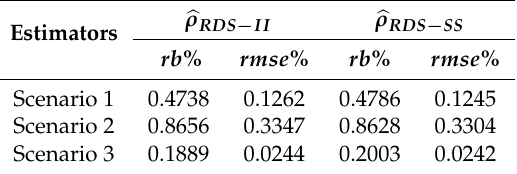
Table 2. Percent relative bias ( rb %) and the relative mean squared error ( rmse %) for estimating the correlation coefficient ρ with estimators (cid:98) ρ RDS − II and (cid:98) ρ RDS − SS in the three